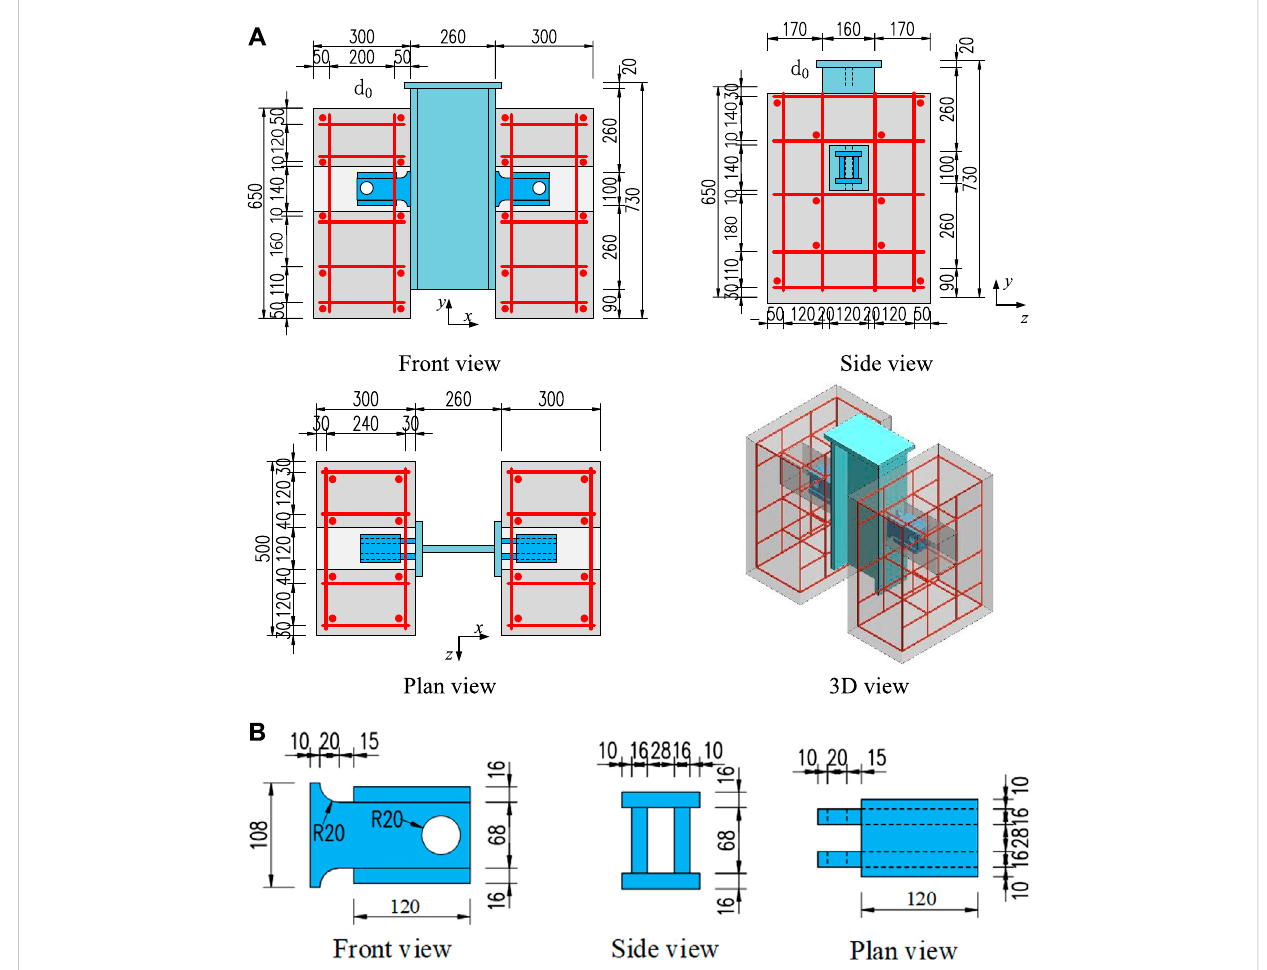
FIGURE 2 (A) Con fi gurationanddimensionsofthespecimenBS-r20-h120(mm)(Zouetal.,2021). (B) Con fi gurationanddimensionsoftheconnectorBS-r20- h120 (mm) (Zou et al., 2021).